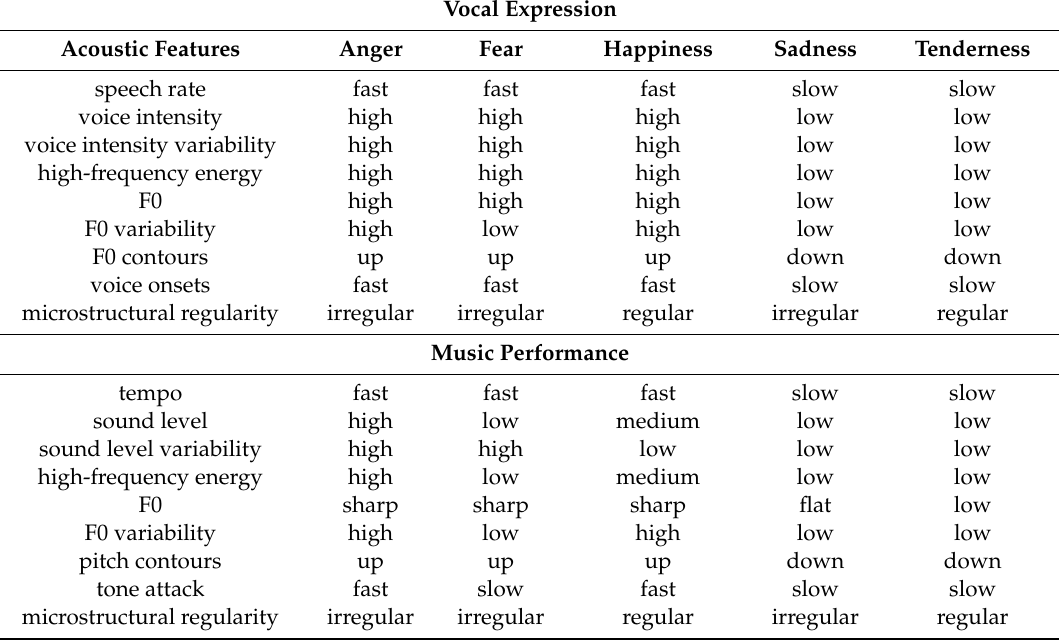
Table 1. Acoustic feature characteristics of discrete emotions expressed in speech and music